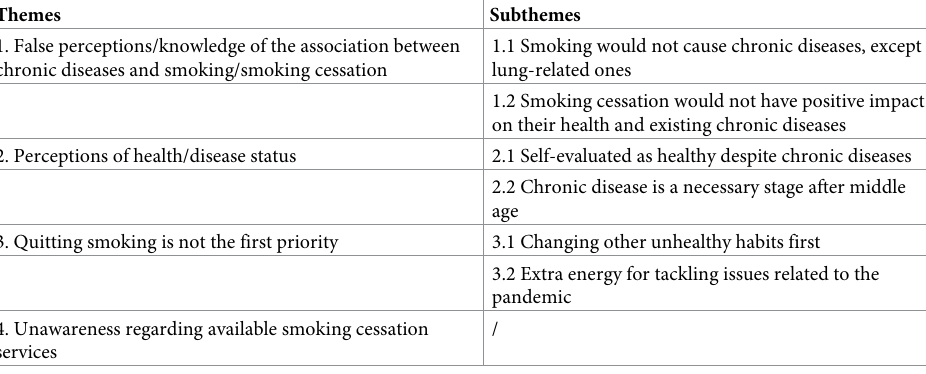
Table 2. Themes and subthemes from the semi-structured interviews.